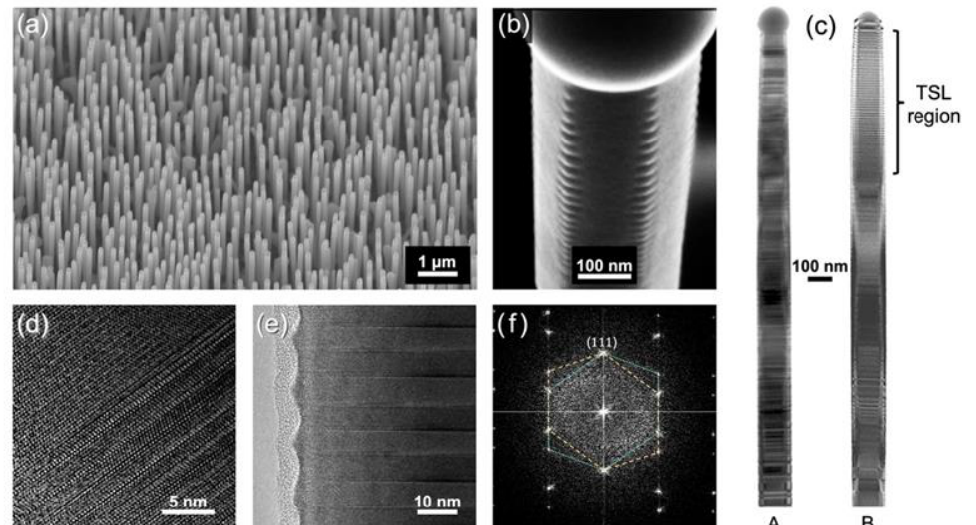
Figure 2. ( a ) SEM image of the NW array from sample B; ( b ) SEM image of a NW top, showing surface faceting due to a TSL; ( c ) Side-by-side TEM images of a polytypic NW from sample A (left) and a TSL NW from sample B (right); ( d ) HRTEM image near the center of the same NW from sample A, showing a polytypic WZ/ZB NW structure; ( e ) HRTEM image near the center of the TSL in sample B; ( f ) Selective-area electron diffraction pattern confirming ZB twins in the TSL region of sample B.